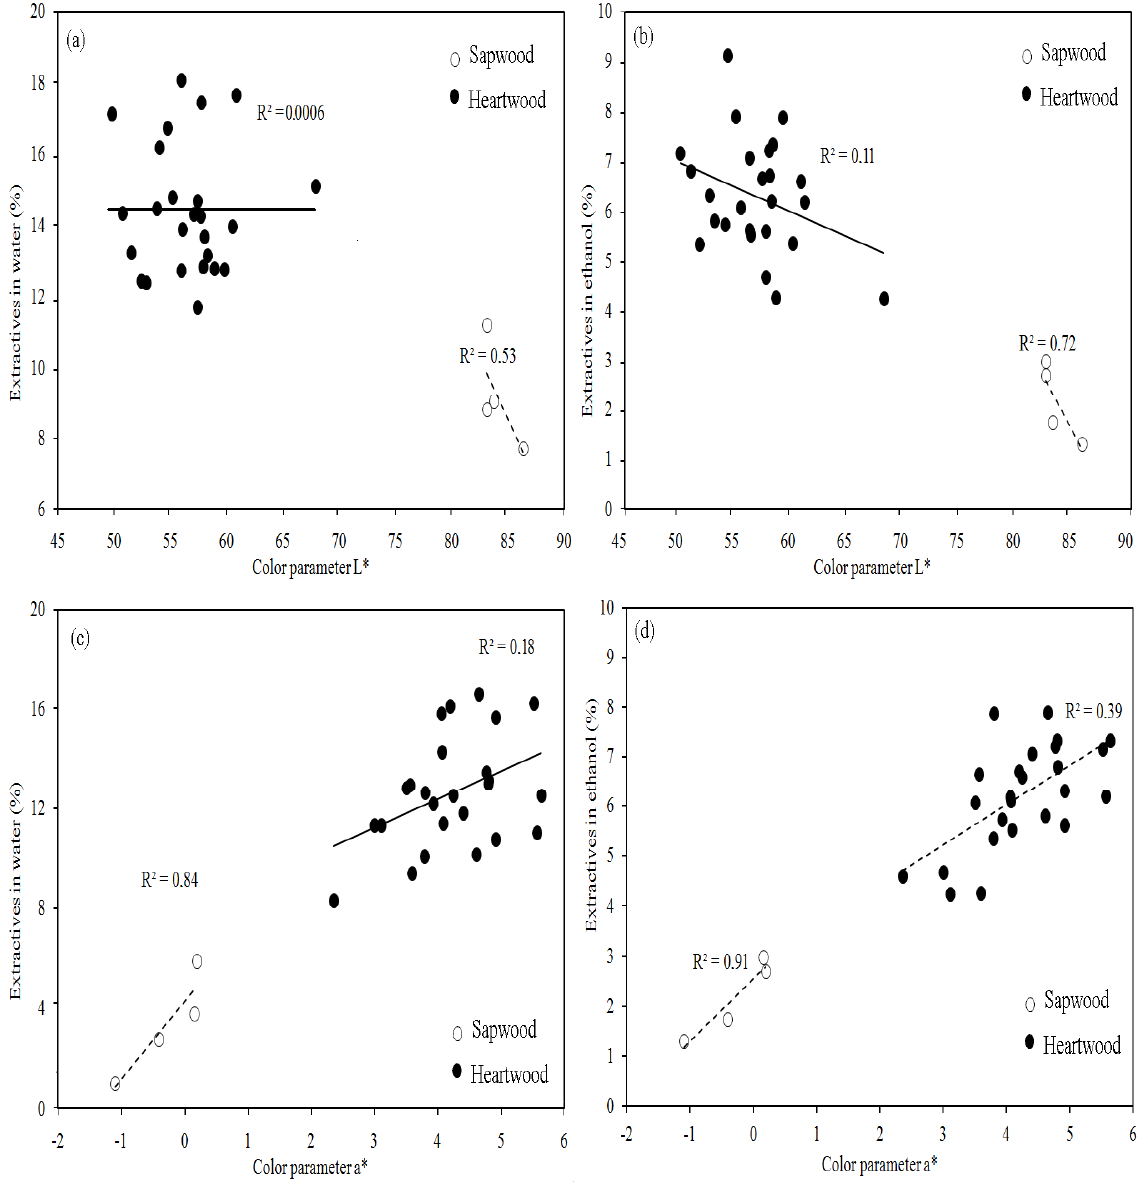
Figure 2. Relationship between extractives in water and ethanol and the L* and a* color parameters in Acacia mangium